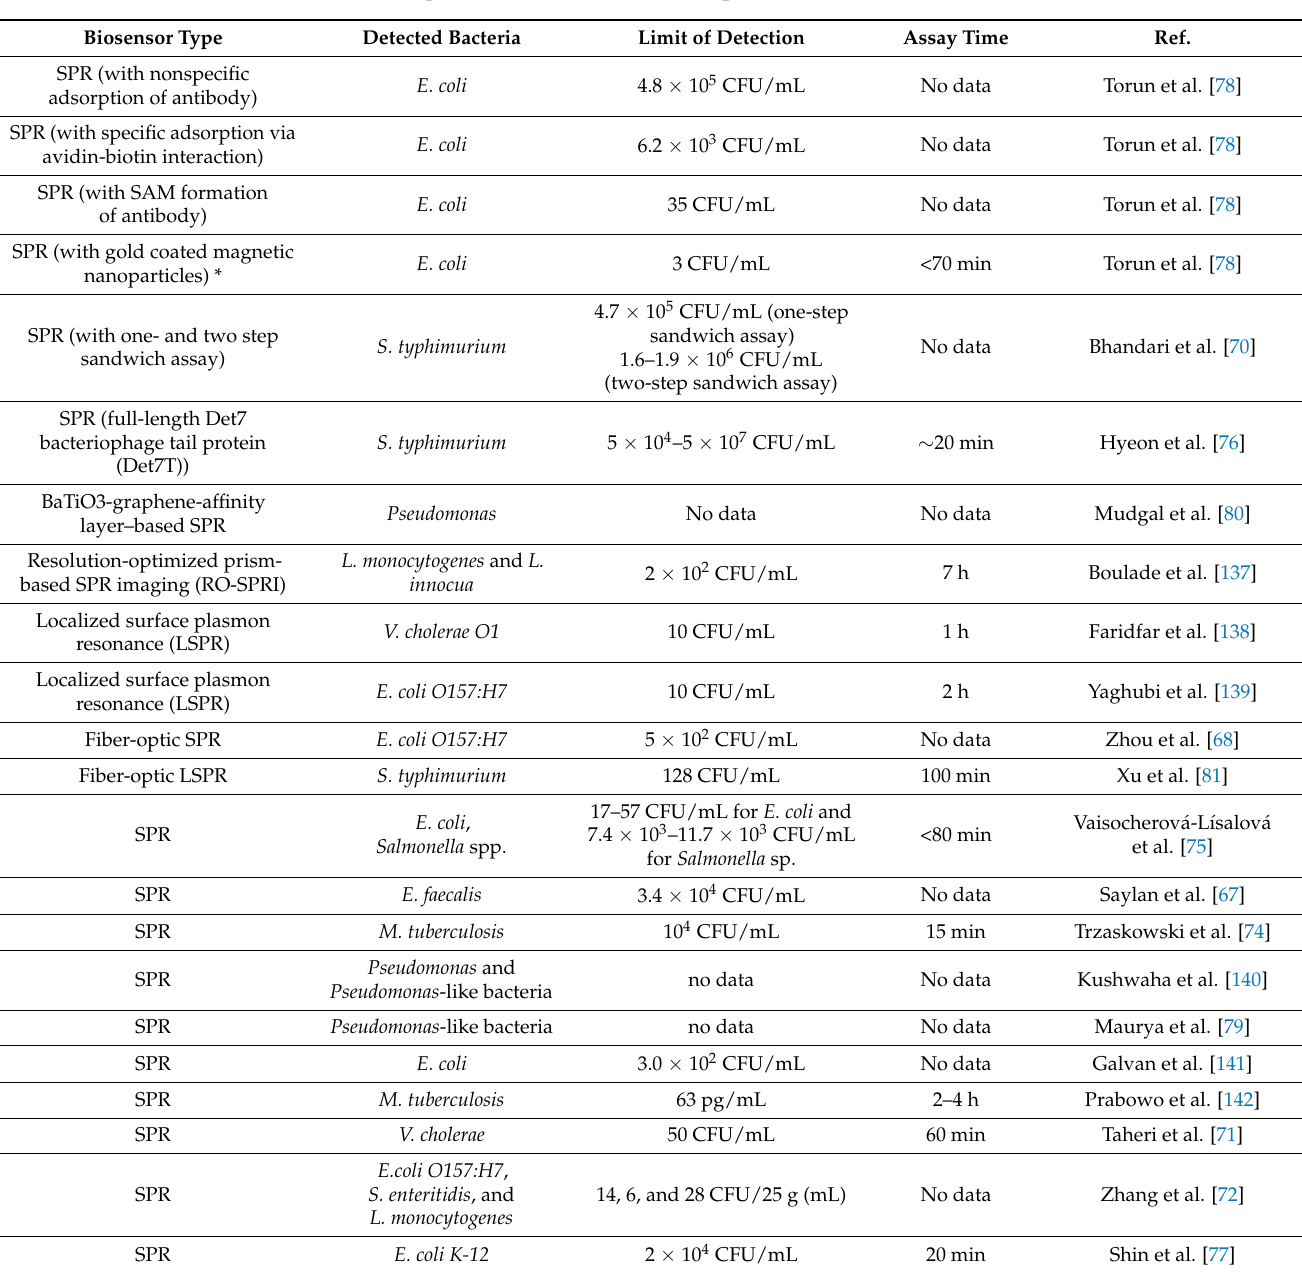
Table 1. Summary of the whole bacteria detecting biosensors. In case of SPR and QCM, the different sensing strategies result in various limit of detection values (LOD). Thus, according to these results, the sensitivity of the biosensors can be improved by some development, for example applying nanoparticles. In general, the assay time is less than 1 h. (* represents label-based biosensors for direct comparison with label-free